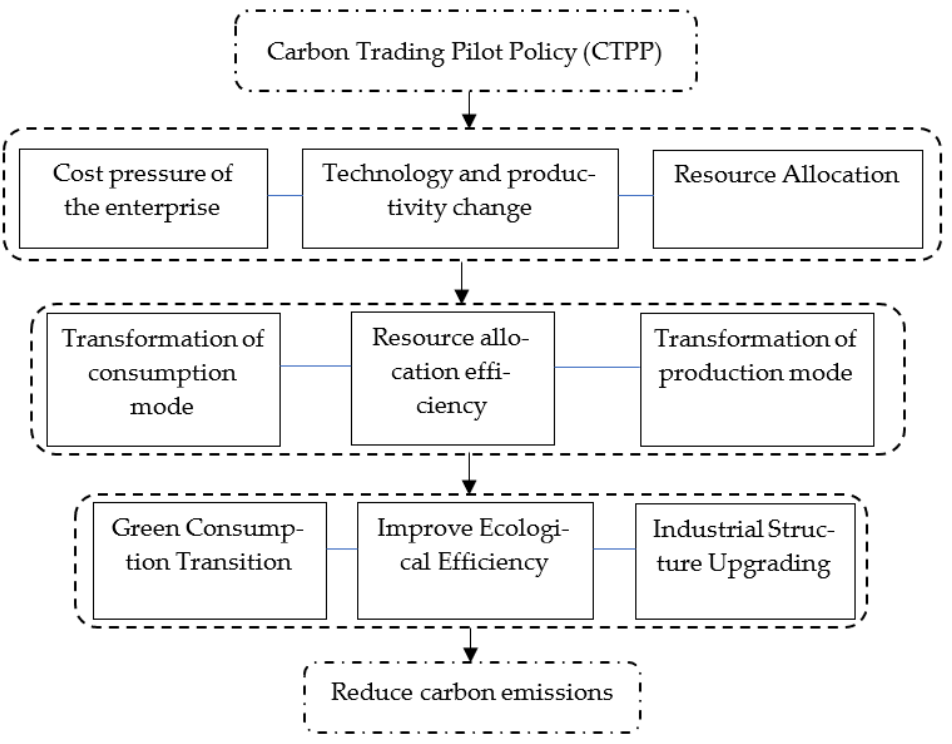
Figure 2. Action mechanism of environmental regulation and carbon emission reduction. (Source: Authors’ construct).